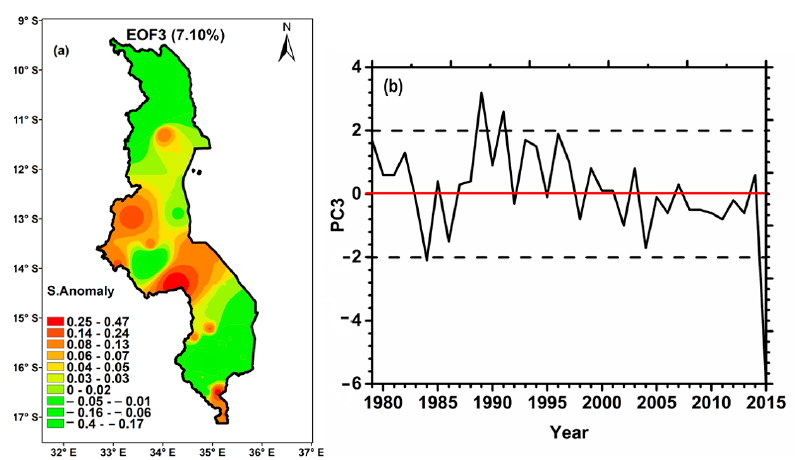
Figure 6. EOF 3 of the wet season precipitation. ( a ) Spatial variability and ( b ) its corresponding PC over Malawi based on data from 31 rainfall stations during 1979–2015.